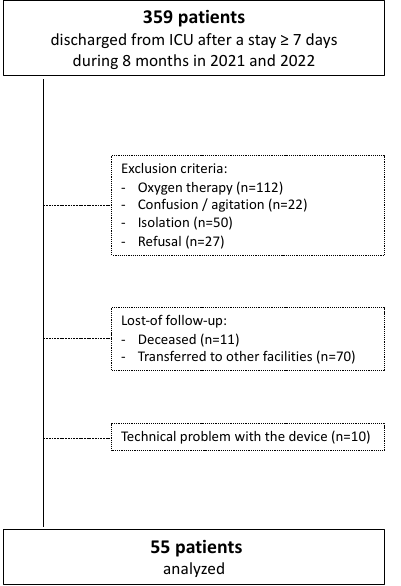
Figure 1. Flow chart. The characteristics of the patients are detailed in Table 2. Table 2. Patients’ characteristics.